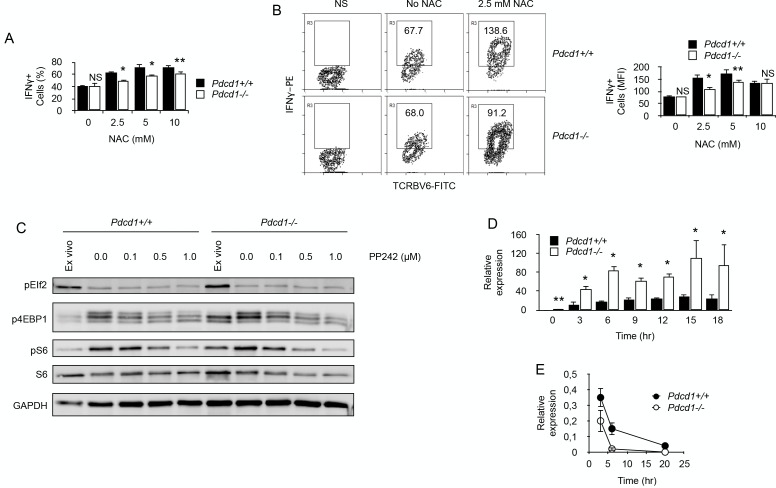
By limiting ROS production, PD-1 maintains functional fitness in chronically stimulated CD4+ T cells.(A) Frequencies (%) of IFNγ-producing cells among purified chronic Pdcd1+/+ or Pdcd1-/- CD4+ T cells stimulated with anti-CD3/CD28 antibodies for 24 hr with or without NAC. After adding Brefeldin for the last 4 hr, cells were labelled for intracellular IFNγ. Mean ± SEM from T cells isolated from 5 mice per group is shown. Data are representative of two independent experiments. * and ** indicate p=0.0079 and p=0.0286, respectively, by the Mann-Whitney test. NS indicates non-significant. (B) Relative IFNγ production among purified chronic Pdcd1+/+ or Pdcd1-/- CD4+ T cells stimulated with anti-CD3/CD28 antibodies for 24 hr with or without NAC as in D. After adding Brefeldin for the last 4 hr, cells were labelled for intracellular IFNγ. Mean of MFI ± SEM from T cells isolated from 5 mice per group is shown. Data are representative of two independent experiments. * and ** indicate p=0.0079 and p=0.0286, respectively, by the Mann-Whitney test. NS indicates non-significant. (C) Western blotting analysis of mTORC1-dependent control of protein translation. Phosphorylation status of mTORC1 targets S6 protein and 4EBP1 was analysed in chronic Pdcd1+/+ or Pdcd1-/- CD4+ T cells ex vivo or after stimulation with anti-CD3/CD28 antibodies for 48 hr with or without mTOR inhibitor PP242. Analysis of EIf2 phosphorylation was used as a specificity control. Data are representative of three independent experiments. (D) Relative expression of IFNγ mRNA in chronic Pdcd1+/+ or Pdcd1-/- CD4+ T cells stimulated by anti-CD3/CD28 antibodies for the indicated periods of time. Data (mean ± SD) are representative of two independent experiments including 4 mice per group. * and ** indicate p=0.0079 and p=0.0286, respectively. (E) Analysis of IFNγ mRNA decay in chronic Pdcd1+/+ or Pdcd1-/- CD4+ T cells stimulated by anti-CD3/CD28 antibodies. Data (mean ± SD) are one experiment including 4 mice per group.